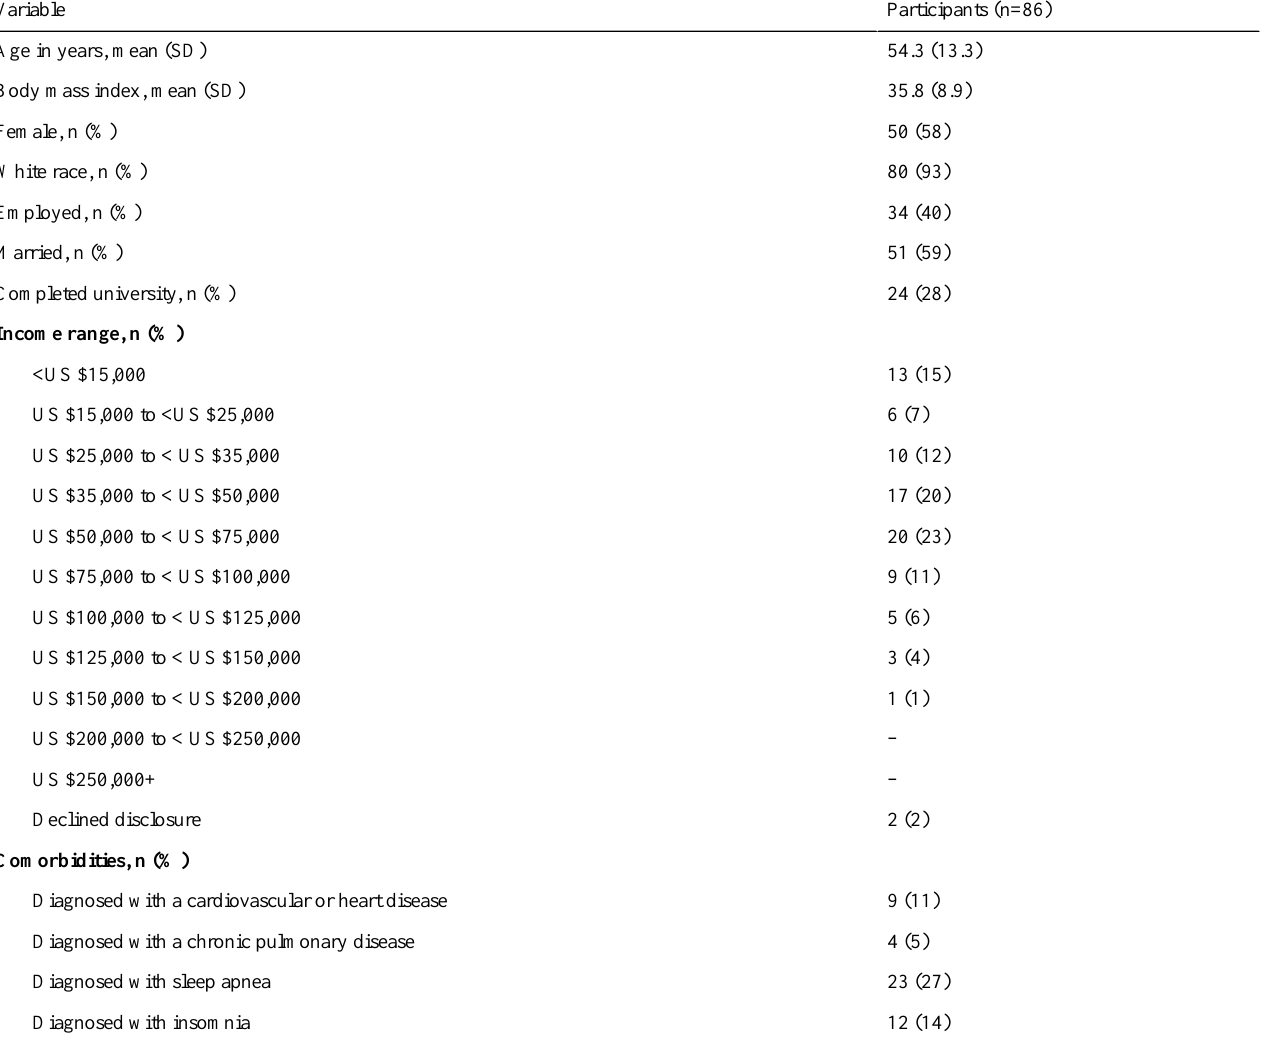
Table 1. Sociodemographic characteristics of participants.